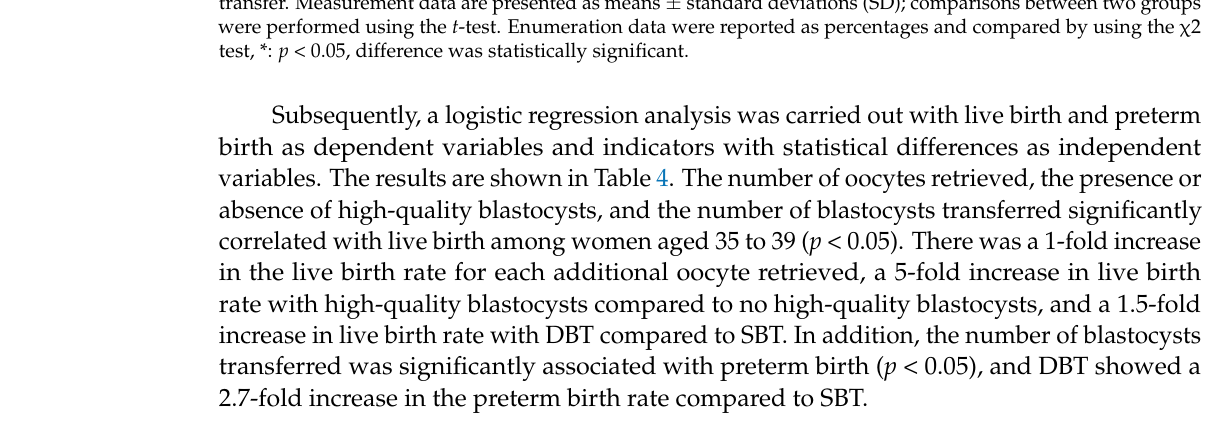
Table 4. Multivariate logistic regression analysis of possible correlates of live birth and preterm birth in the middle group (women aged between 35 and